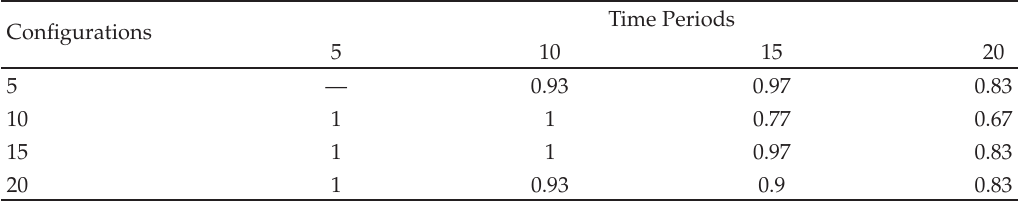
Table 4: Percentage of MDTC model solve times within 10 minutes (cid:2) 30 trials conducted per parameterization (cid:3)